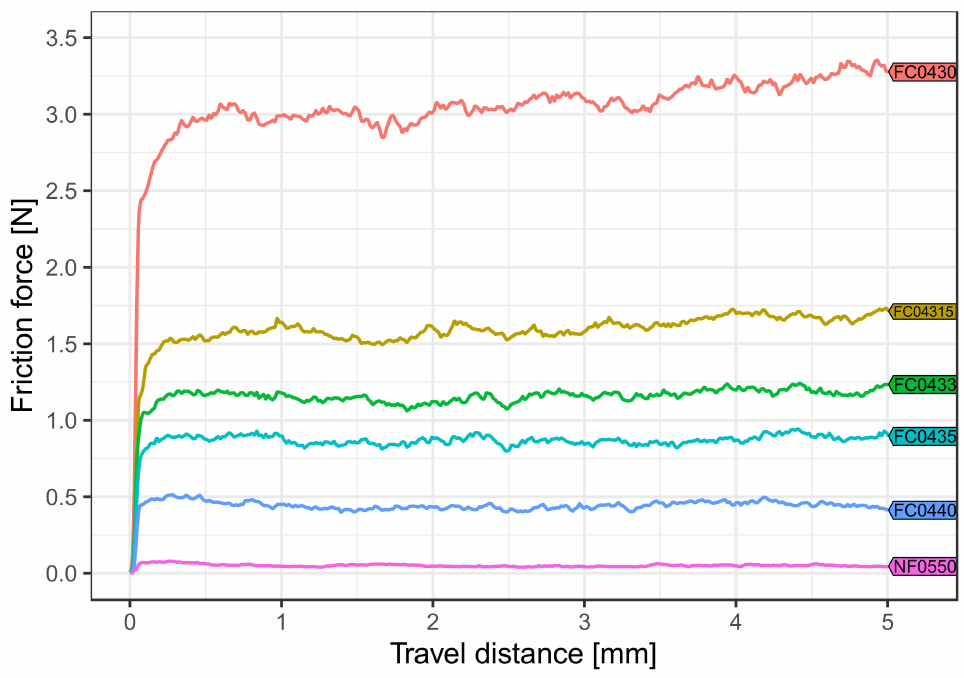
Figure 6. Effect of dry storage at room temperature. Depending on the design and inner width of an additional covering, average forces of 0.4–3.1 N were generated. The V-shaped archwire with V-slot showed a frictional force close to zero with non-friction covering NF0550